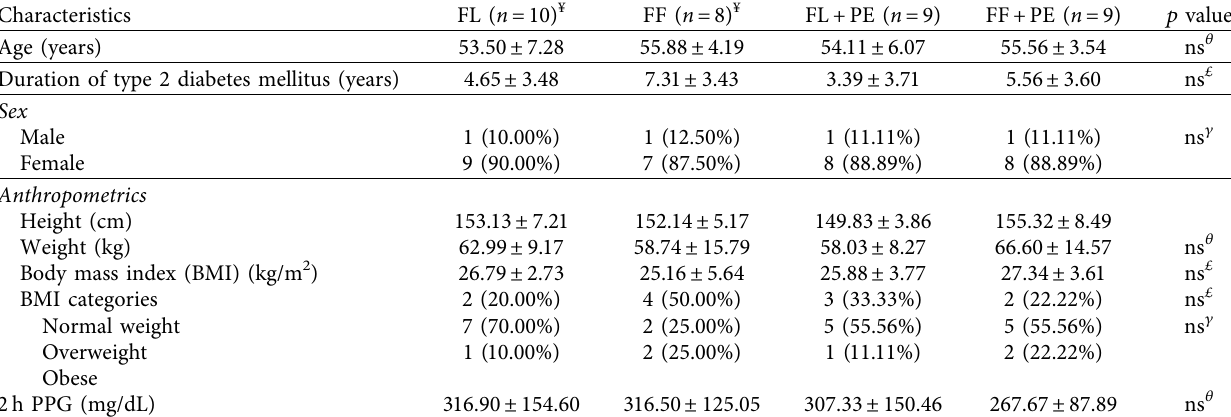
Table 1: Basic characteristics of research participants from four diferent groups.